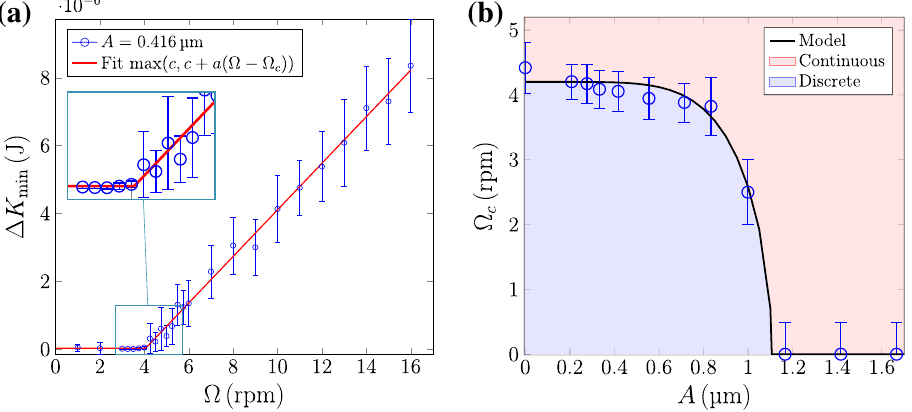
Figure 3. ( a ) Minimum of the total kinetic energy for A = 0.416 µ m . For the sake of clarity in the figure, the other amplitudes are not plotted. By fitting the linear piecewise function � K min = max ( c , c + a (� − � c )) it is possible to obtain the critical rotation speed, (cid:31) c , for each amplitude where the transition is observed ( A (cid:31) 1 µ m ). ( b ) Critical rotation speed, (cid:31) c , as a function of the forcing amplitude A . The continuous black line corresponds to the theoretical model described in the following